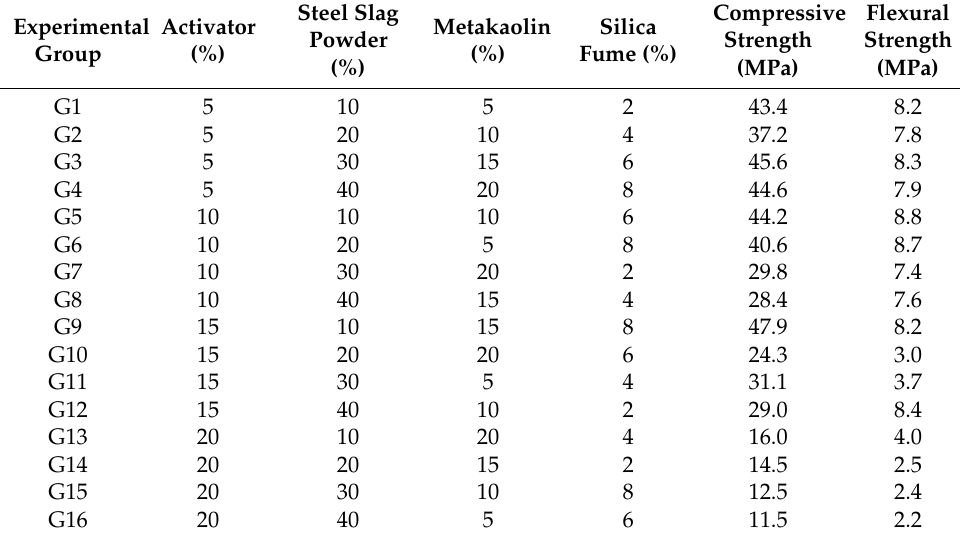
Table 5. Orthogonal experimental results of mechanical